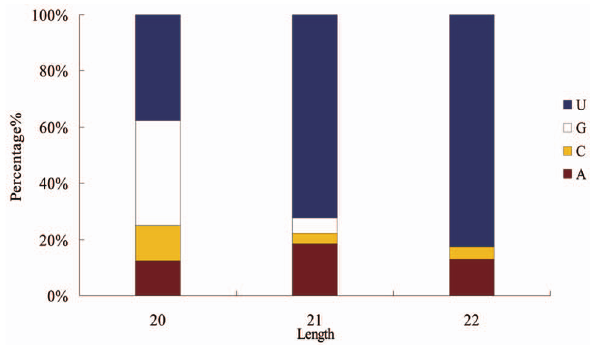
Figure 3. First nucleotide bias of novel candidate miRNAs in andromonoecious poplar female and male flower